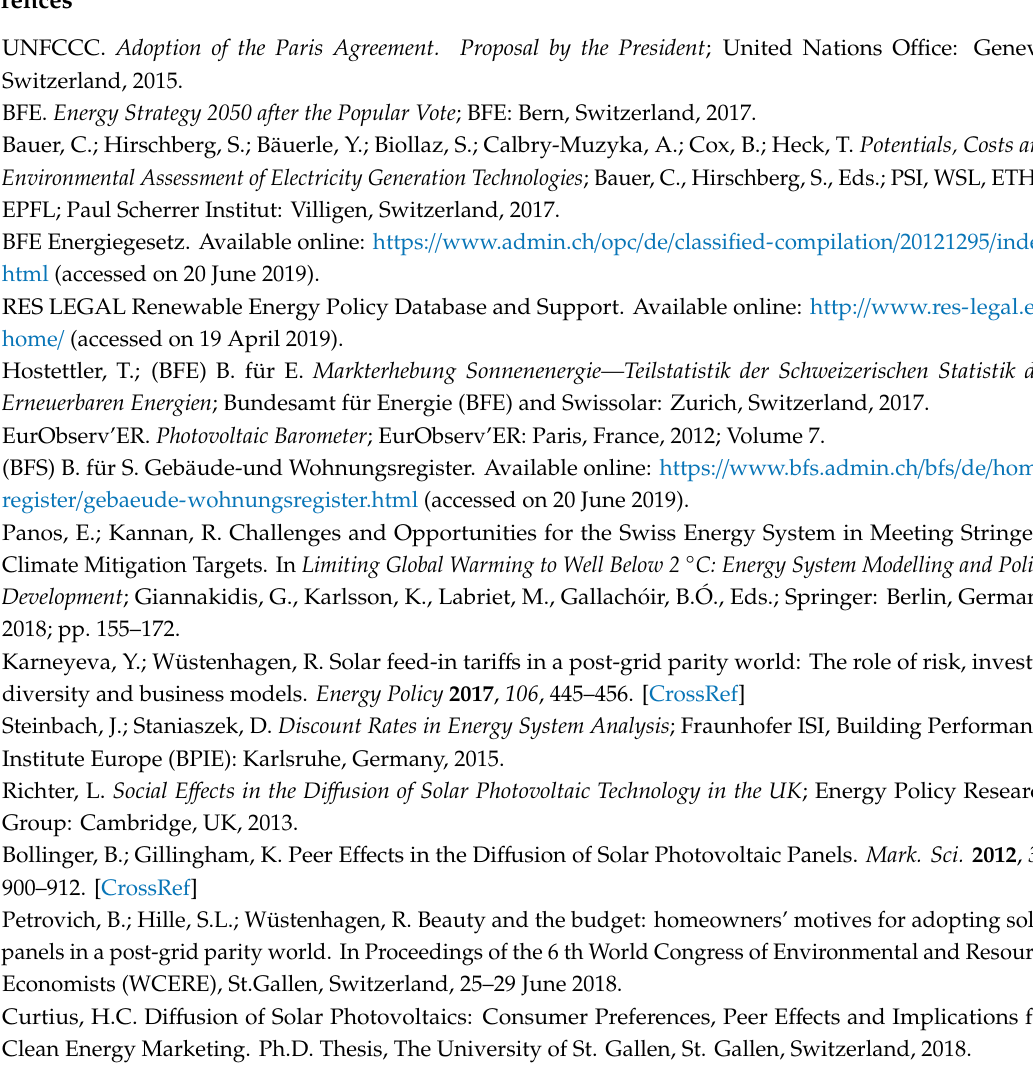
Figure A6. Estimated elasticity of the financial partial utility to the policy intensity. The table on the left ( a ) presents the estimated output, while the figure on the right ( b ) presents the actual, fitted, and residual plots. A tipping point is visible, in which an abrupt change in the financial utility takes place when the policy intensity exceeds a threshold (the threshold depends on the investment costs and electricity prices).